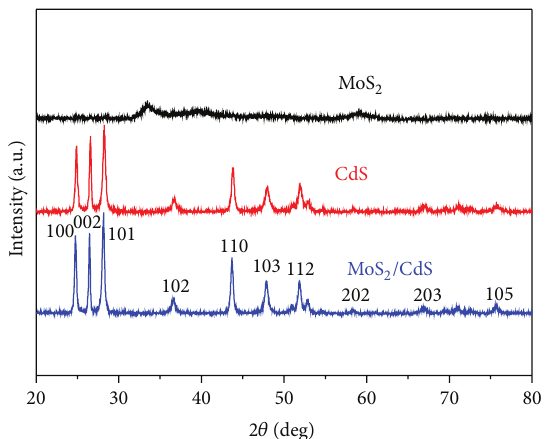
Figure 3: XRD of MoS 2 , CdS, and MoS 2 /CdS.